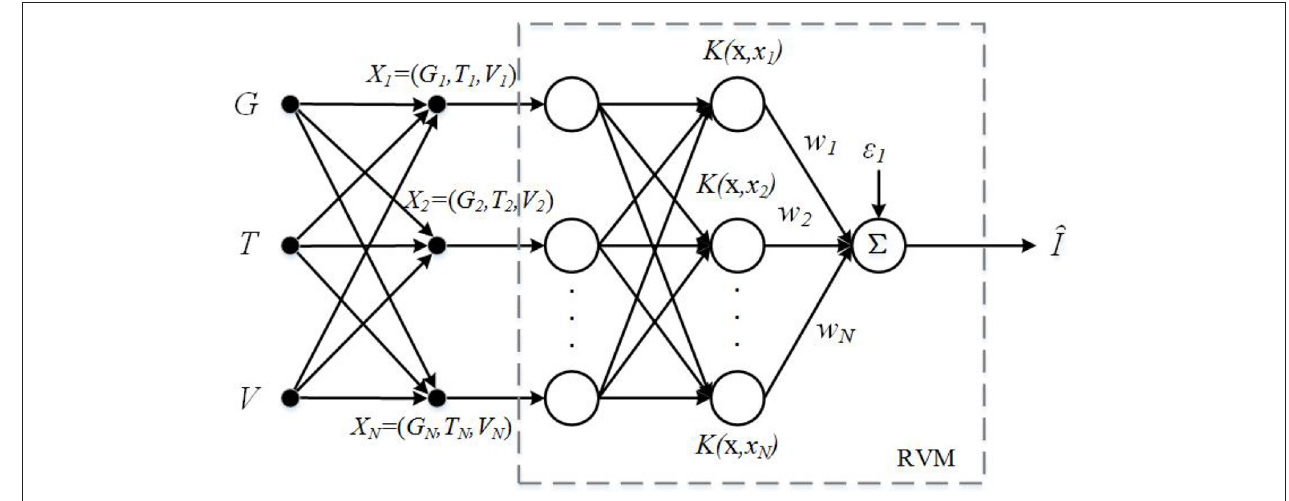
FIGURE 1 | An RVM PV model for obtaining I - V curves for modules in the